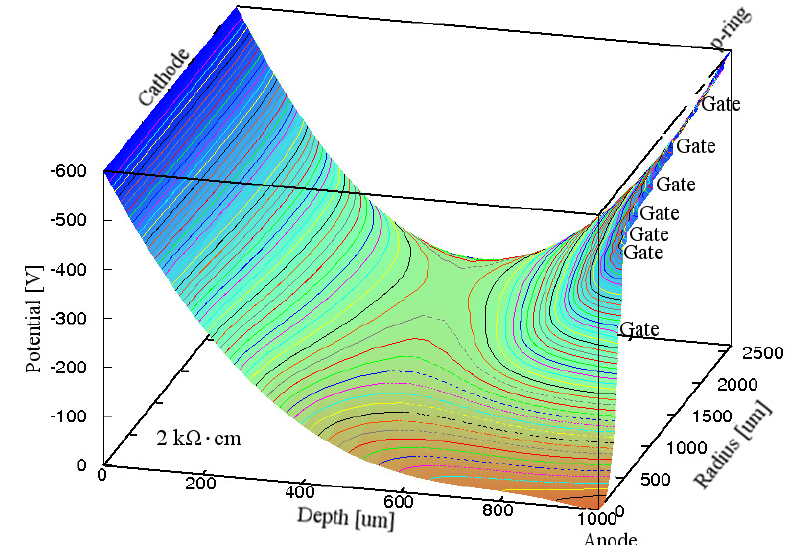
Figure 7. Simulated electric potential distributions in the Si substrate inside the p-ring of a 1 -mm-thick GSDD with R of 3 . 5 mm and ρ of 2 k Ω · cm for Gate D. A reverse bias chip Si voltage of − 600 V was applied to the cathode, p-ring, and seven gates. Equipotential lines are shown at 10 V